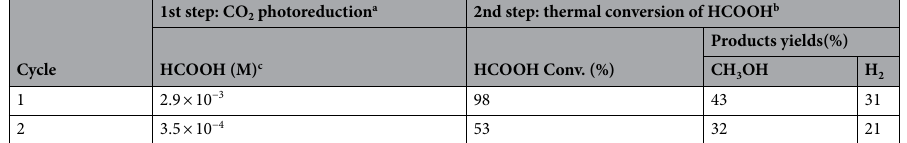
Table 3. Recycling experiment of the overall conversion of CO 2 into methanol and hydrogen. a